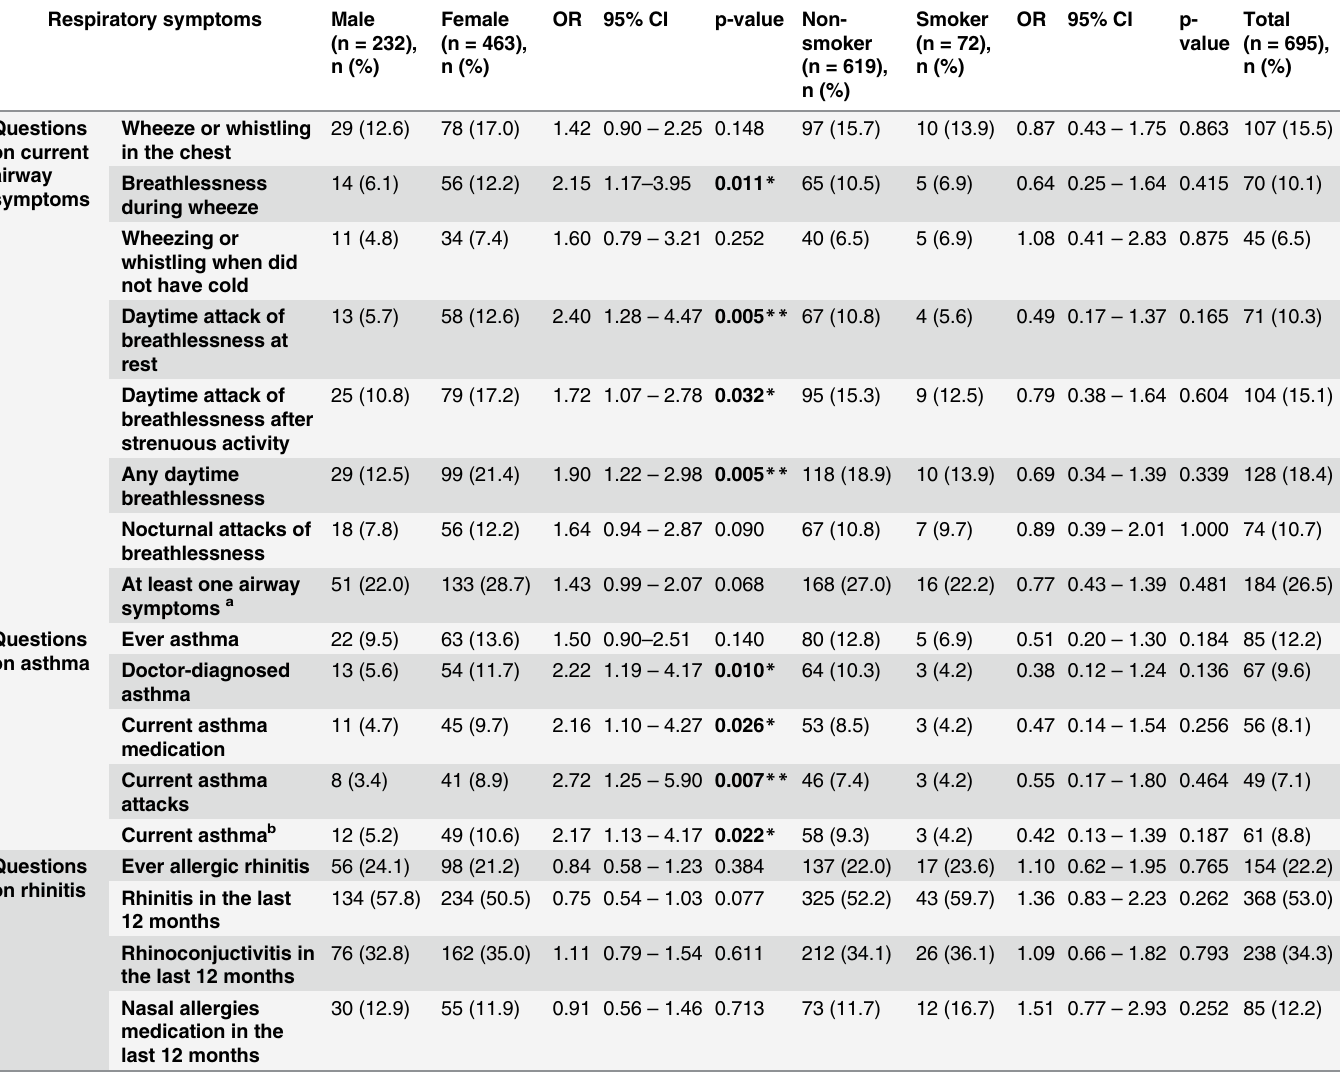
Table 1. Asthma and respiratory symptoms among office workers, stratified for gender and smoking (n = 695). Respiratory